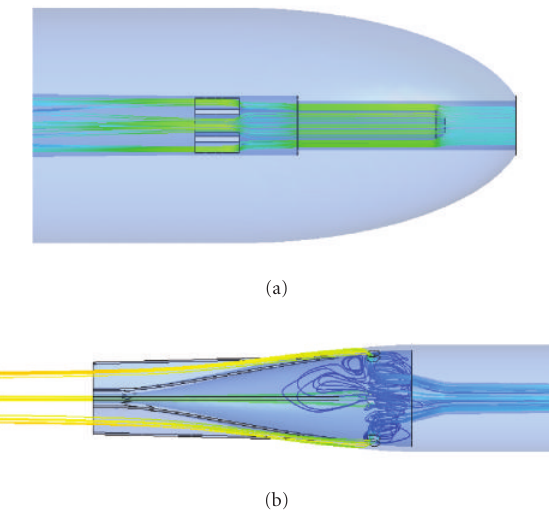
Figure 6: Streamline patterns through the center channel of a probe [31].